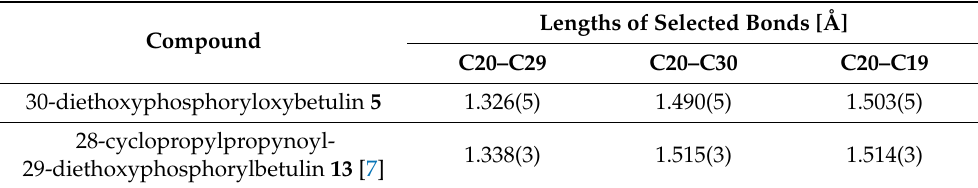
Table 4. Effect of 30-phosphate derivatives of betulin and reference compounds (betulin and cisplatin) on the viability of cells from four cancer cell lines studied.